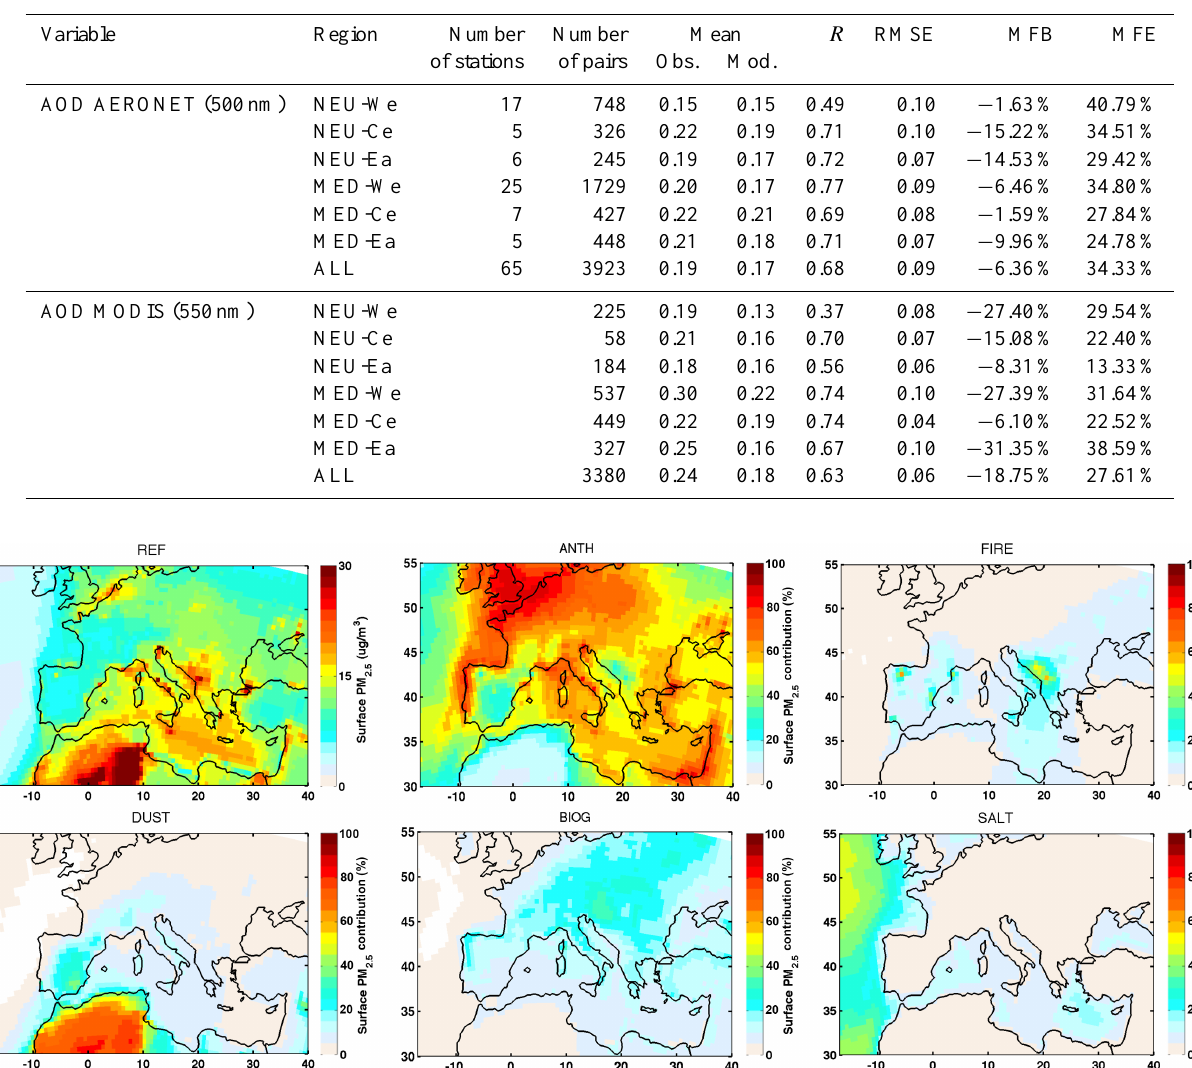
Table 4. Performance statistics of hourly AOD simulated by CHIMERE (Mod.) during the summer of 2012, compared to the coincidently observed AOD from AERONET at 500nm and MODIS at 550nm (Obs.).